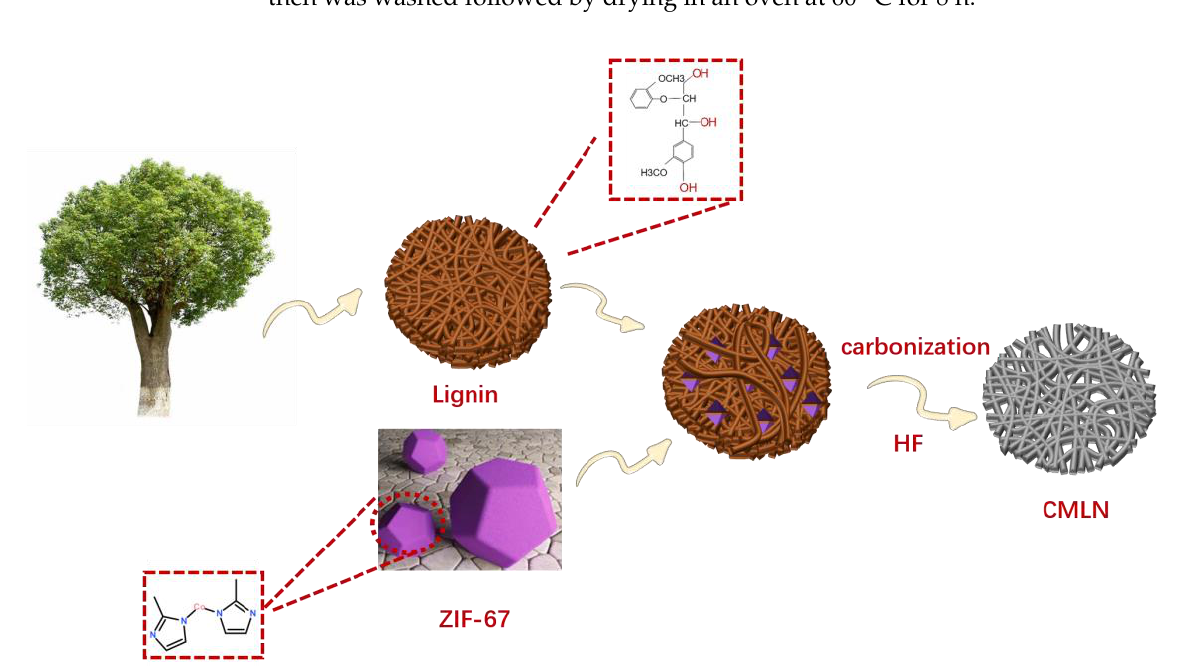
Figure 8. Fabrication process of the CMLN porous carbon.